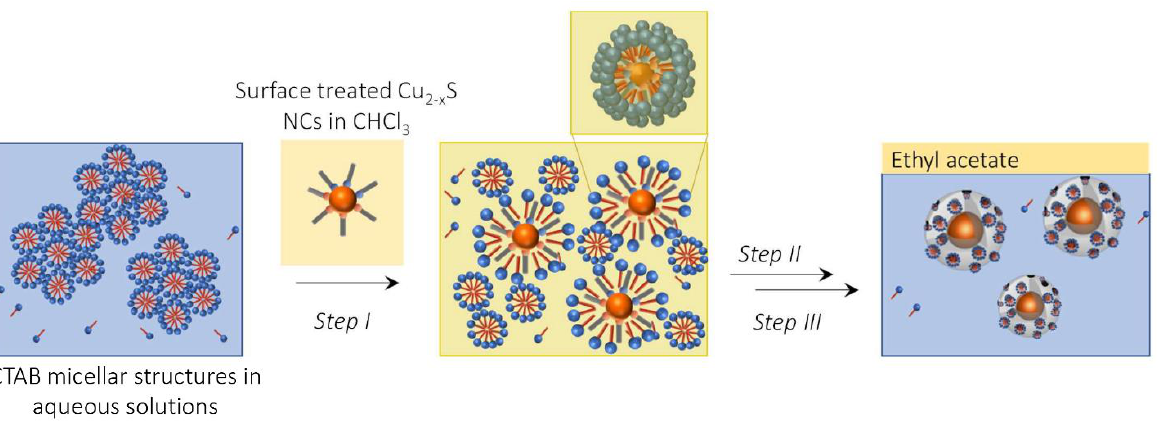
Figure 2. Scheme of the synthetic steps performed to grow the mesoporous silica shell coating the Cu 2-x S nanocrystals. Cu 2 − x S